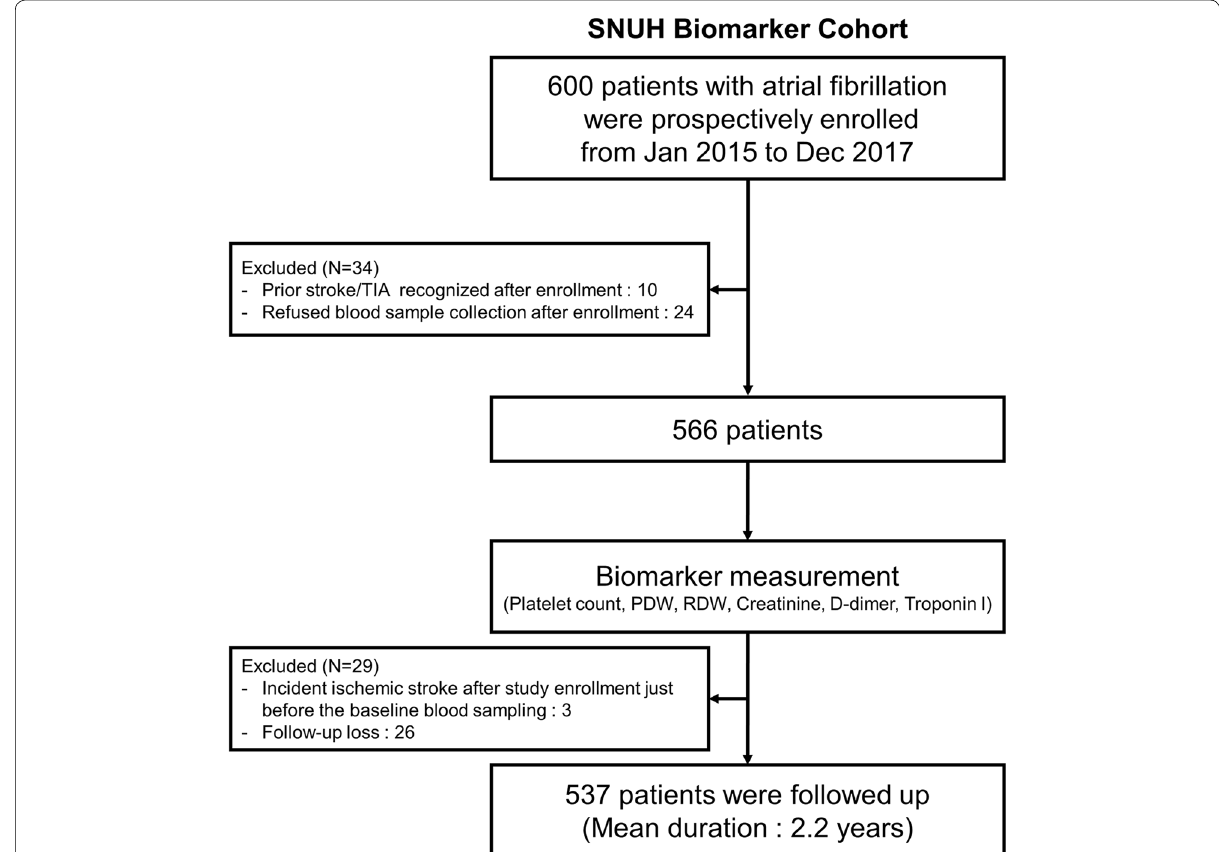
Fig. 1 Study flow. PDW, platelet distribution width; RDW, red cell distribution width; TIA, transient ischemic